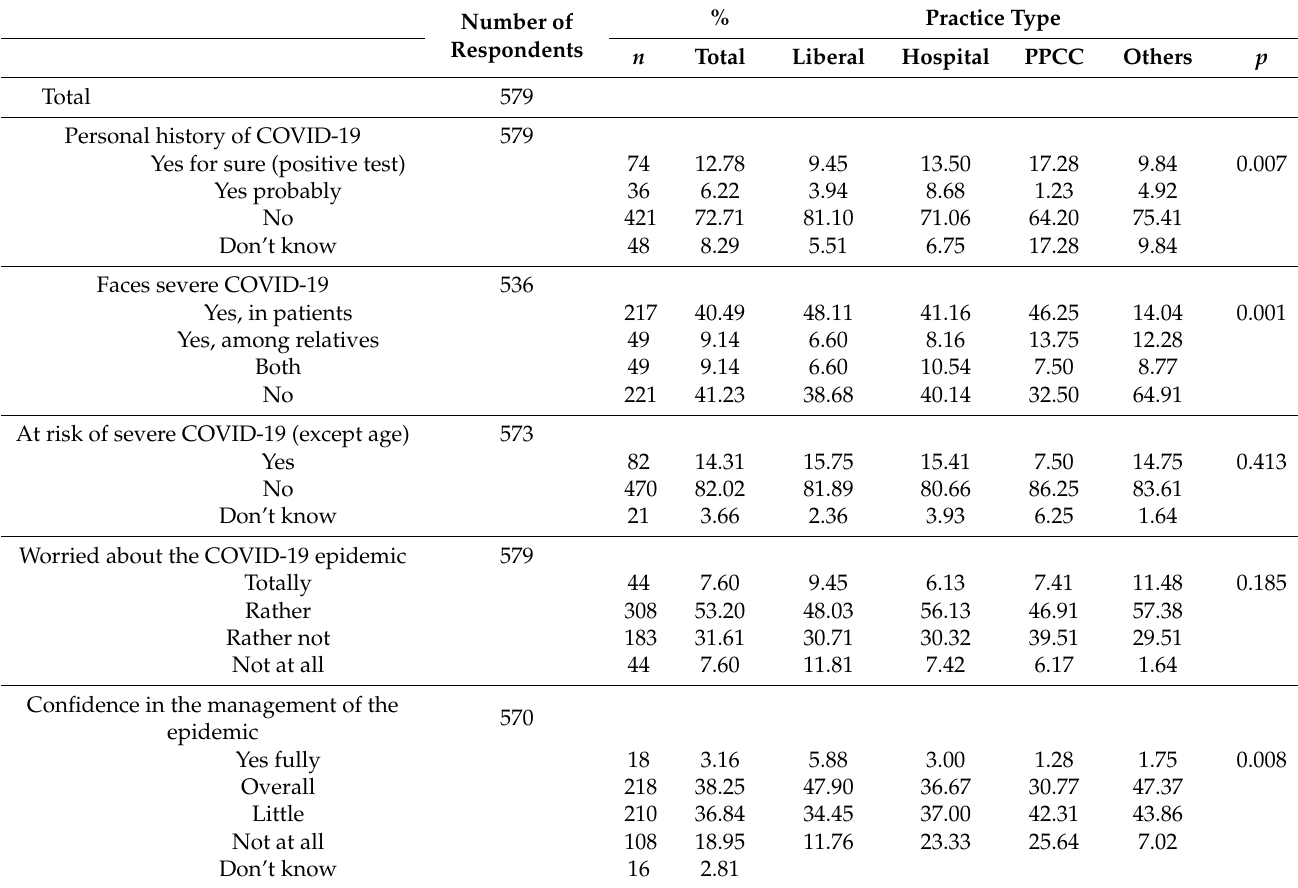
Table 2. History and concerns about COVID-19, by exercise